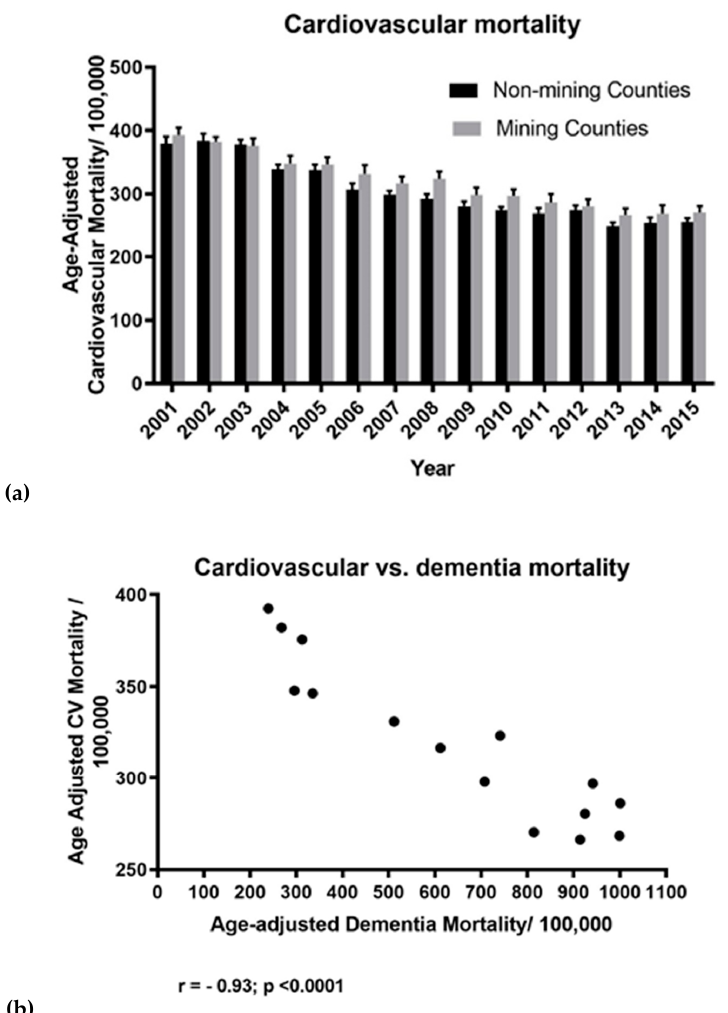
Figure 10. Cardiovascular disease in MTM vs. non-mining counties in West Virginia over the years spanning 2000–2015. ( a ) A two-factor repeated measures ANOVA showed a significant difference (decline) in cardiovascular deaths over this period (F = 63.25; df = 14, 714; p < 0.0001). Although a possible trend was evident, there was no significant effect of MTM when analyzed over the 15 year period (F = 2.84; df = 1, 51; p = 0.097). Likewise, there was no interaction of year with mining (F = 0.64; df = 14, 714; p = 0.82). ( b ) A Pearson’s r product-moment correlation analysis (mining counties alone) over the 15 year period revealed a significant negative correlation between cardiovascular mortality/100,000 per year vs. the cumulative age-adjusted dementia mortality/100,000 per year (r = − 0.93; p < 0.0001; 15 xy pairs).